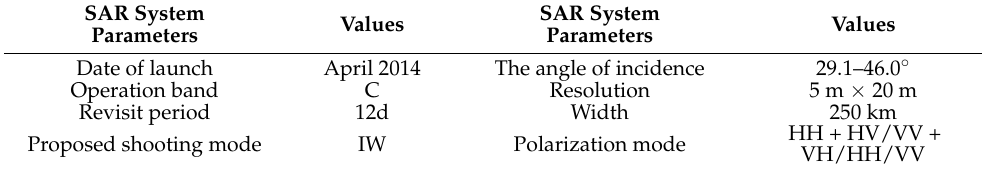
Table 1. Sentinel-1 satellite SAR sensor major